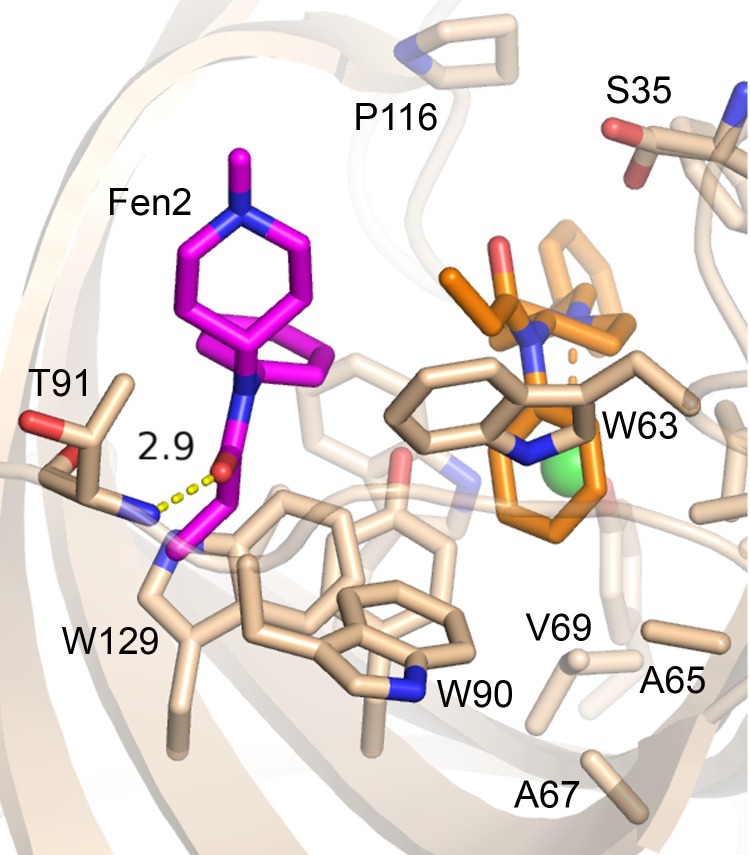
A second molecule of fentanyl was observed on the periphery of the Fen49 binding site.The phenylethyl moiety points towards the solvent and could not be modeled in 2 of the 3 copies in the asymmetric unit due to disorder. The second fentanyl makes a hydrogen bond to the backbone amide of Thr91 via its carbonyl oxygen.